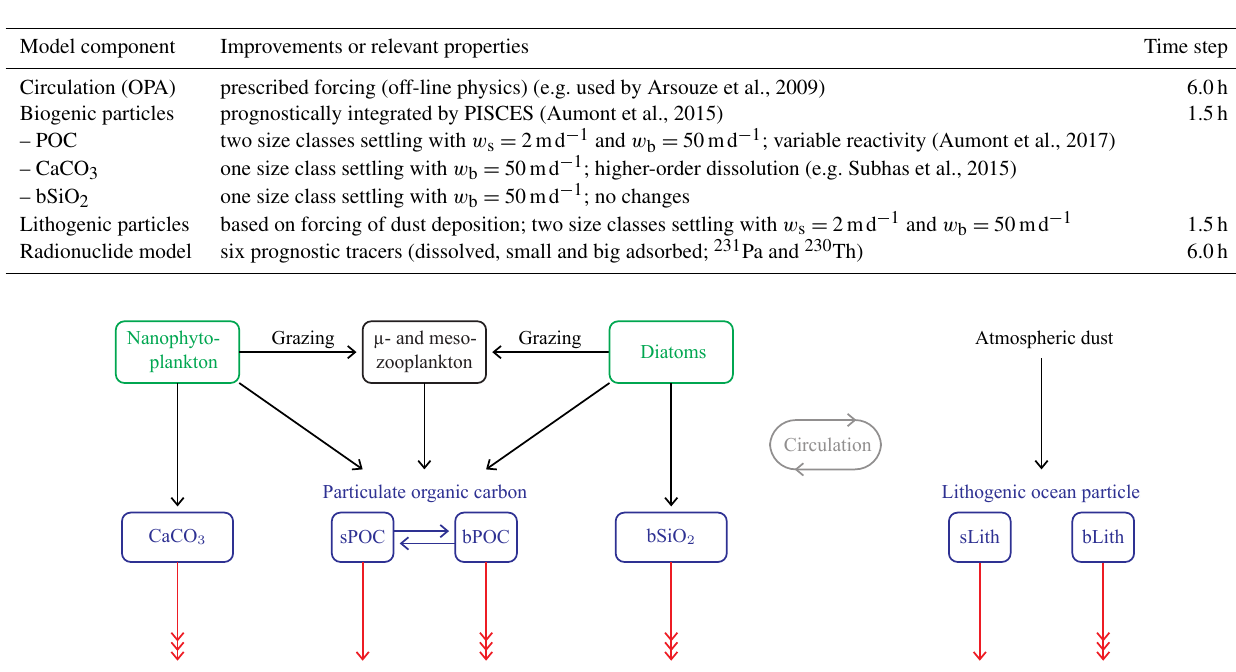
Table 1. Model components and properties essential for the radionuclide model. OPA stands for Océan PAralalisé.